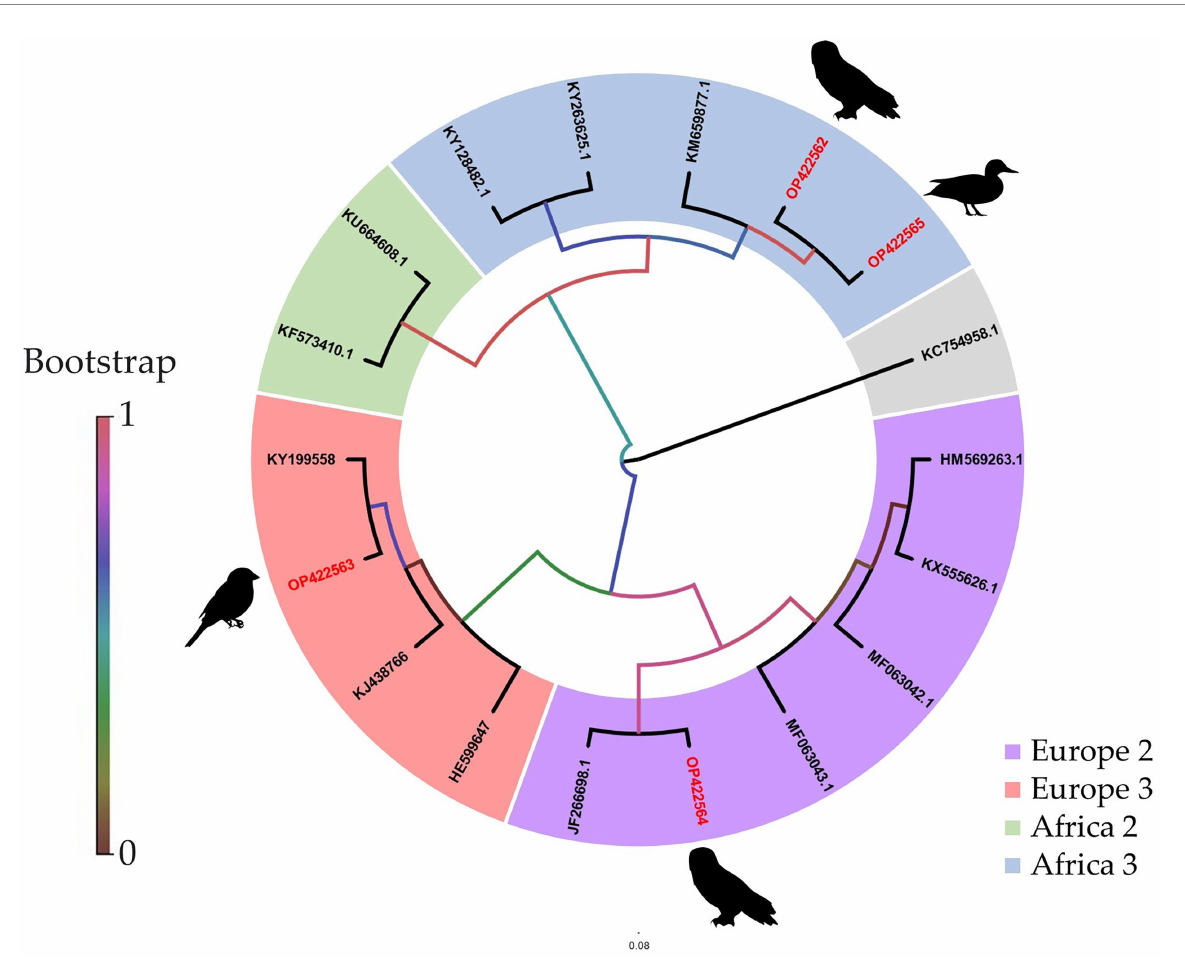
FIGURE 4 Phylogenetic analysis of USUV whole-genome strains detected in birds from Germany. The sequences from Germany generated in this study via MinION amplicon are highlighted in red. Sequences are labeled by codes containing the GenBank accession number. The phylogenetic trees were identical independent of the platform used (Sanger, Illumina, or MinION amplicon) and therefore only one is illustrated